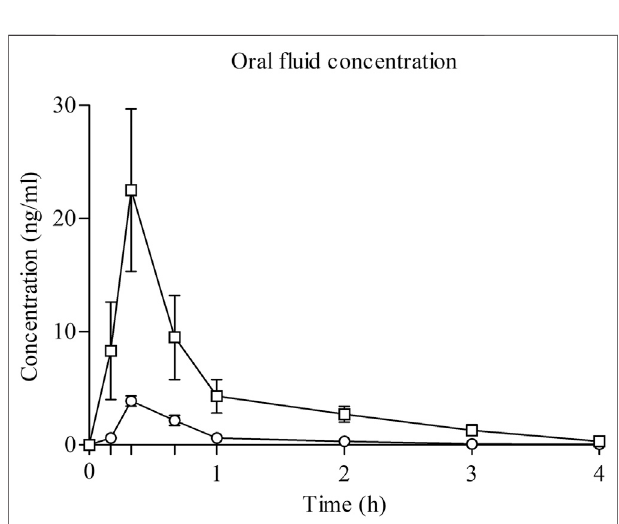
FIGURE 2 | Time course of JWH-122 ( n (cid:1) 8) and JWH-210 ( n (cid:1) 7) concentrations in oral fl uid. ○ JWH-122; □ JWH-210; values are mean and standard